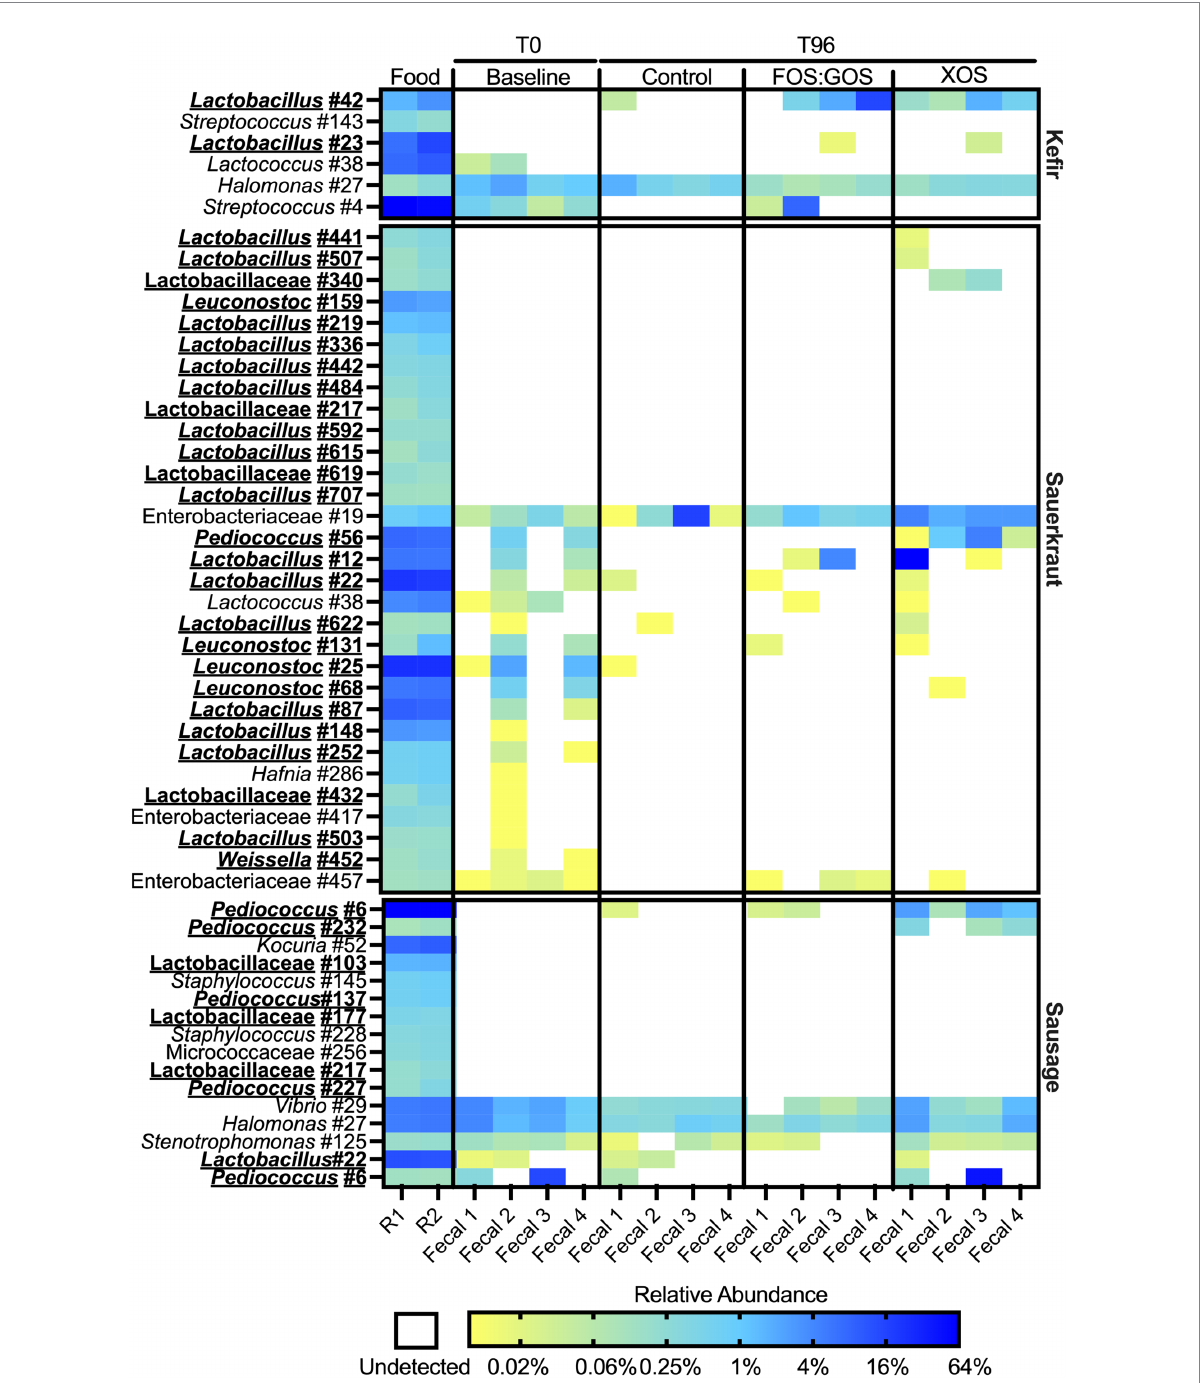
FIGURE 7 Most fermented food bacteria fail to persist in vitro . Persistence of OTUs present at ≥ 0.1% relative abundance in fermented foods was assessed following culture for 96 h in the presence (FOS:GOS, XOS) or absence (Control) of prebiotics. Relative abundance of OTUs in fecal samples prior to inoculation with fermented foods (Baseline) was also plotted. Shading represents the percent relative abundance. The identity of each OTU is on the left axis; the fermented food inoculated is on the right axis. OTUs that classify as members of the family Lactobacillaceae are indicated by bold-face, underlined typeface. The fermented food replicate number (R1 or R2) and identity of fecal samples are at the bottom of the